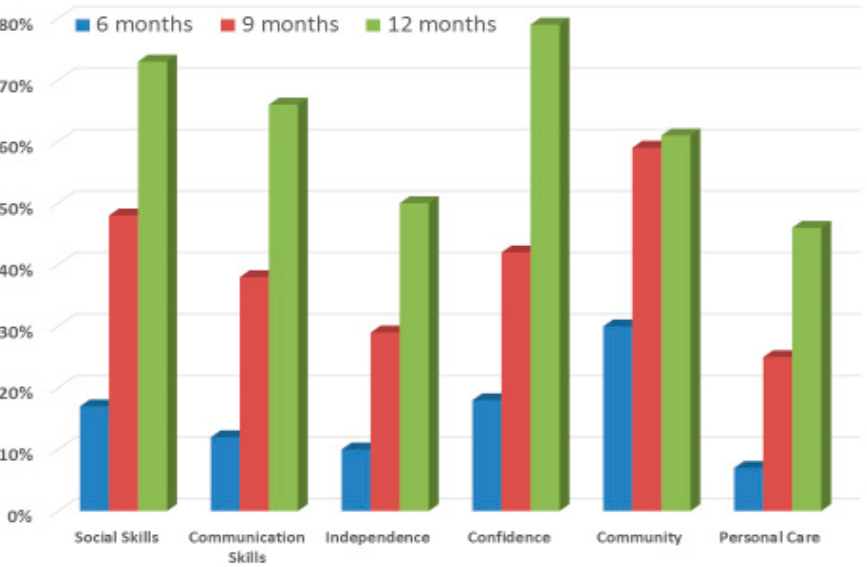
Figure 1. The percentage of children rated as ‘much better’ in each domain at the three reviews.